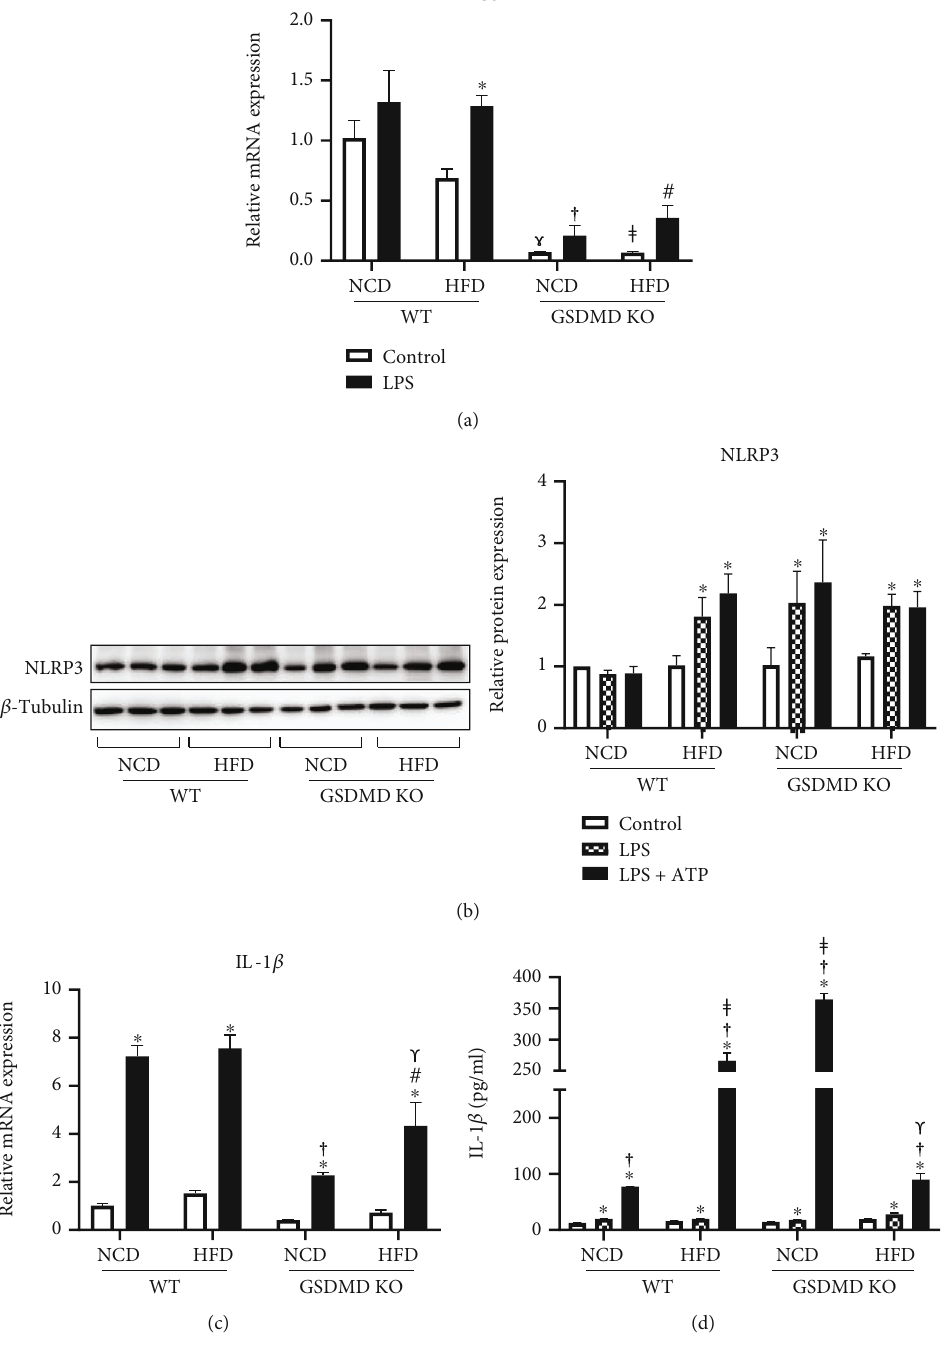
Figure 6: Macrophage activation in wild-type (WT) and gasdermin D knockout (GSDMD KO) mice fed a high-fat diet (HFD). (a and c) Bone marrow-derived macrophages were isolated from WT and GSDMD KO mice fed a normal chow diet (NCD) or HFD. Bone marrow- derived macrophages (BMDMs) were treated with LPS, and gene expression of GSDMD and IL-1 β was measured by real-time PCR. Gene expression levels were normalized to 18S rRNA. (b) Representative western blot image and quanti fi cation of NLRP3 after LPS and ATP treatment. Protein expression levels were normalized to β -tubulin. (d) Secretion of IL-1 β protein from BMDMs was measured by ELISA after treatment with LPS and ATP. ∗ p < 0 : 05 vs. control, † p < 0 : 05 vs. LPS, ‡ p < 0 : 05 vs. NCD LPS+ATP, and ɤ p < 0 : 05 vs. HFD